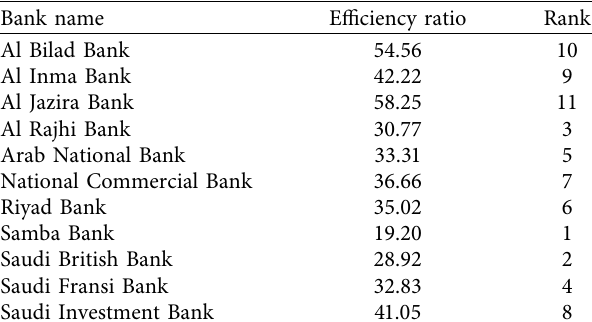
Table 2: Banks’ efficiency ratios and